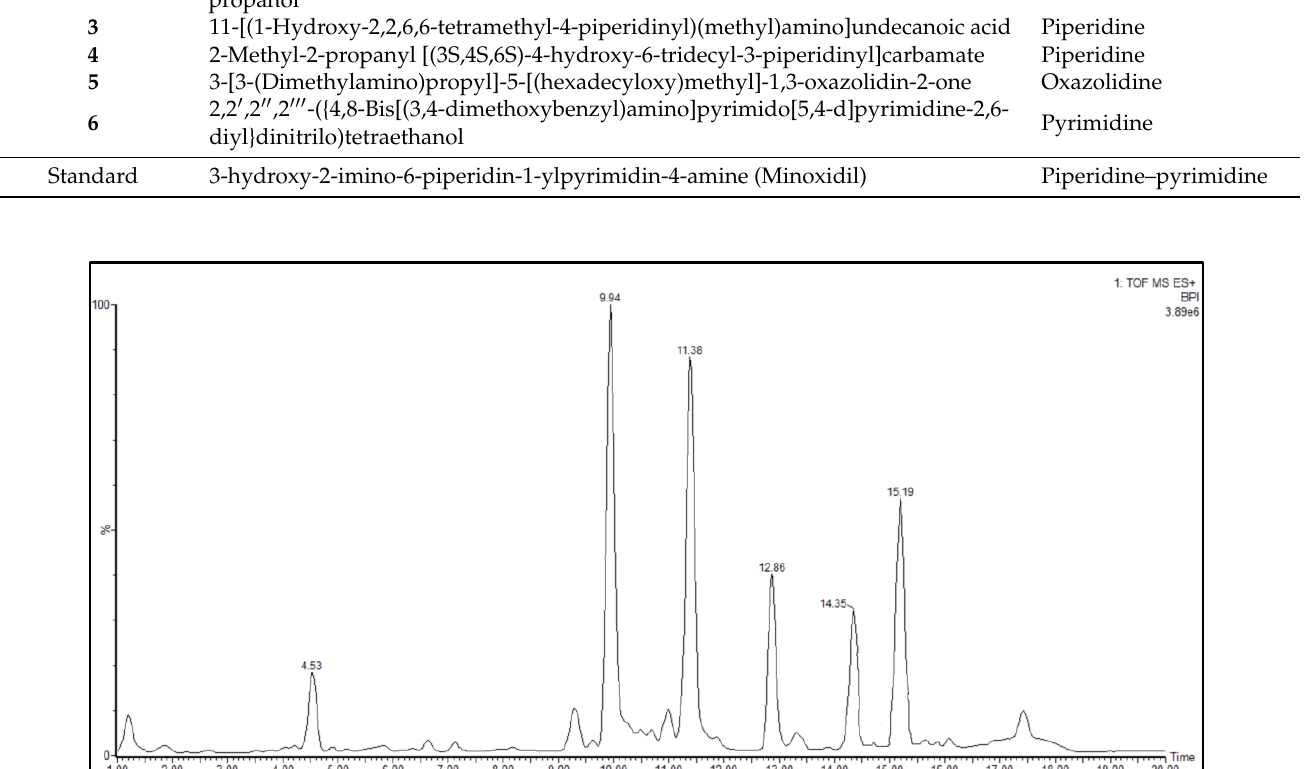
Figure 6. The LC peak chromatogram of FEA-3 sub-fraction. The LC-MS/MS energy positive ionization chromatogram of the sub-fraction FEA-3 showed a high abundance at retention times of 9.94 and 11.38 min with m / z observed at 343.2945 and 371.3281, respectively (Figures S2–S7, Supplementary Materials). Abundant composition appeared at retention times of 12.86 ( m / z 399.3608), 14.33 ( m / z 427.3687), and 15.21 min ( m / z 669.3326), while the low abundance composition appeared at retention times of 4.56 min ( m / z 169.0765) (Table 5). Tracking with the built-in library database instrument revealed a fascinating fact—a group of chemical structures with an alkaloid skeleton was found in the FEA 3 sub-fraction, such as indole, piperazine, piperidine, oxazolidine, and pyrimidine (Table 6). Interestingly, by comparing the skeletal structure of the compound Minoxidil (standard), we found another fact—Minoxidil also contains an alkaloid skeleton of